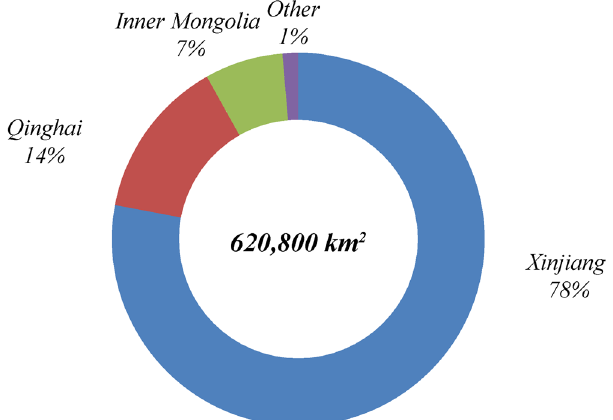
Figure 5. Area and proportion of environmental suitability for Class IV CO 2 capture and storage sites in China.